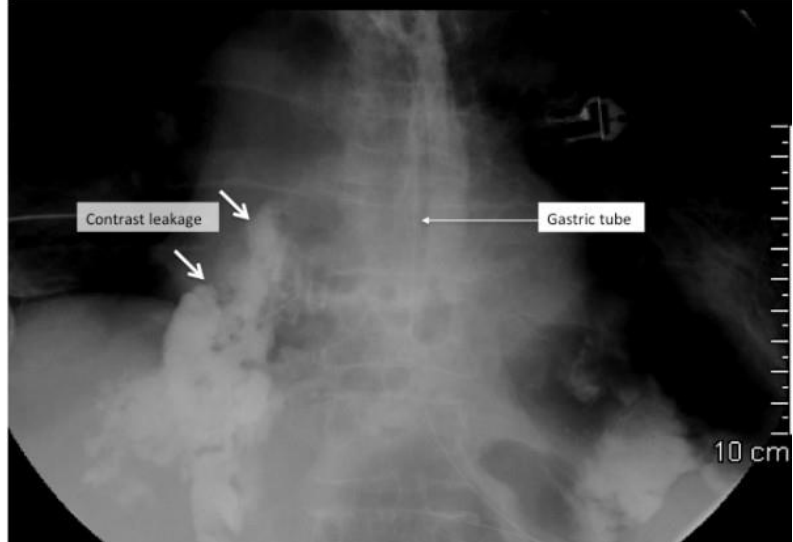
Figure 2. Plain chest radiography with a water-soluble contrast swallow showing contrast leakage in a patient with Boerhaave